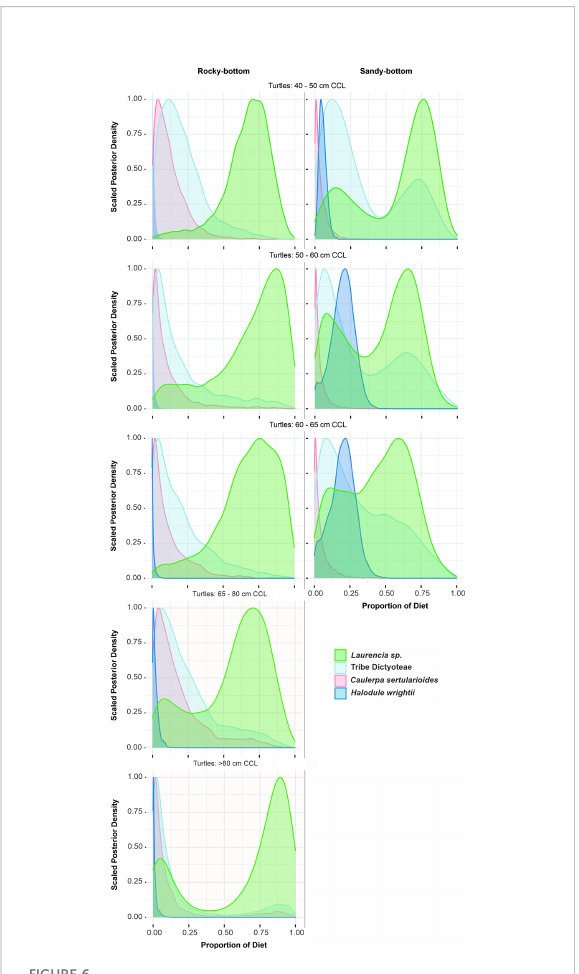
FIGURE 6 MixSIAR density distribution model results showing distributions of the proportion of different benthic algae/seagrass types on the diet of green turtles foraging at Unhocomo and Unhocomozinho, Guinea-Bissau. Left column: turtles captured in a rocky-bottom habitat. Right column: turtles captured in a sandy-bottom habitat. Lines: size classes; the 65 - 80 cm size class of the right column was omitted due to low sample size (n =